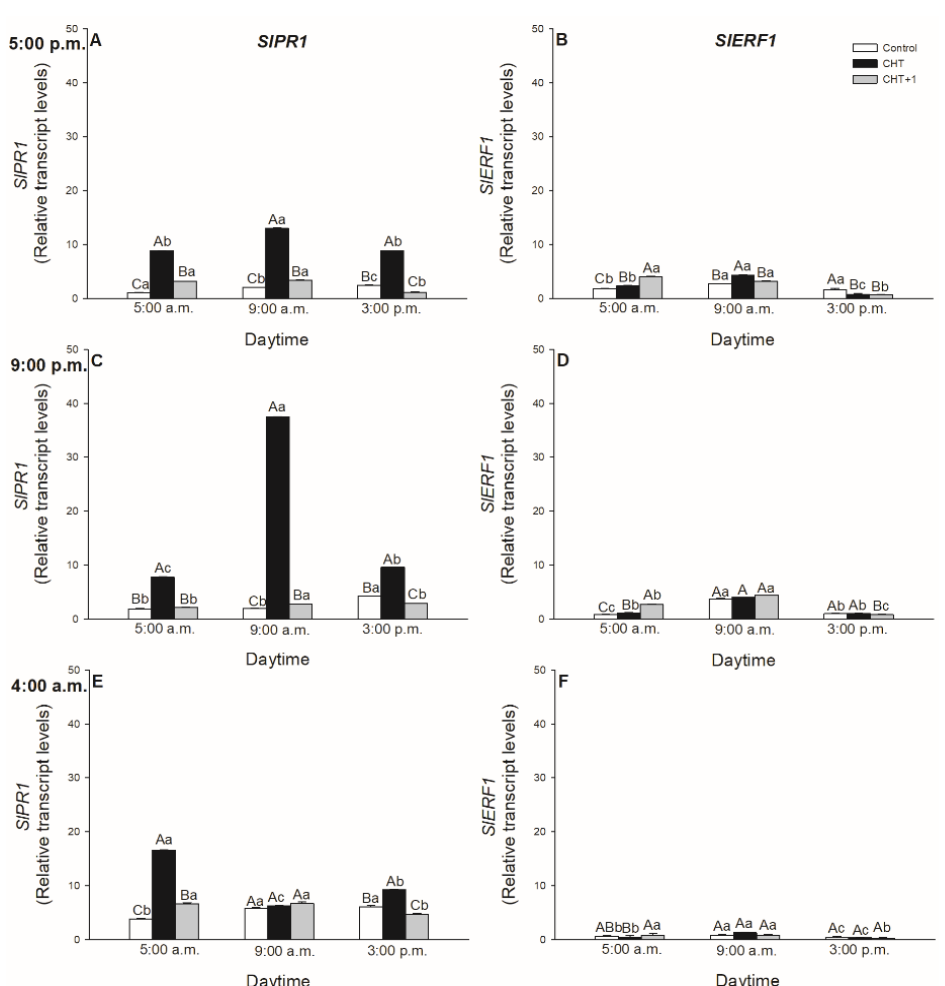
Figure 9. Changes in the relative expression levels of SlPR1 ( A , C , E ) and SlERF1 ( B , D , F ) in leaves of intact tomato plants treated foliar with 100 µ g mL –1 chitosan (CHT) dissolved in the experimental bu ff er (1 mM AA, 10 mM MES / TRIS, 10 mM KCl, 0.1 mM CaCl 2 , pH 6.15) at di ff erent daytimes: at the end of light cycle (17:00 hrs; ( A )), at night (21:00 hrs; ( B )), at dawn (04:00 hrs; ( C )). Measurements were disposed at constant times after treatments (05:00, 09:00, and 15:00 hrs). Means ± SE, n = 3. Means were analyzed by two-way ANOVA, significant di ff erences among the data were analyzed by Holm-Sidak test. Mean values significantly di ff erent at P < 0.05 were signed with di ff erent letters, upper case letters indicate the e ff ects of the treatment at the same daytime, and lower case letters indicate the e ff ects of the daytime under the same treatment. (Control: treatment with 1 mM Acetic acid bu ff er (AA); CHT: treatment with 100 µ g mL –1 chitosan in experimental bu ff er containing AA; CHT + 1: untreated distal leaf level from the CHT-treated